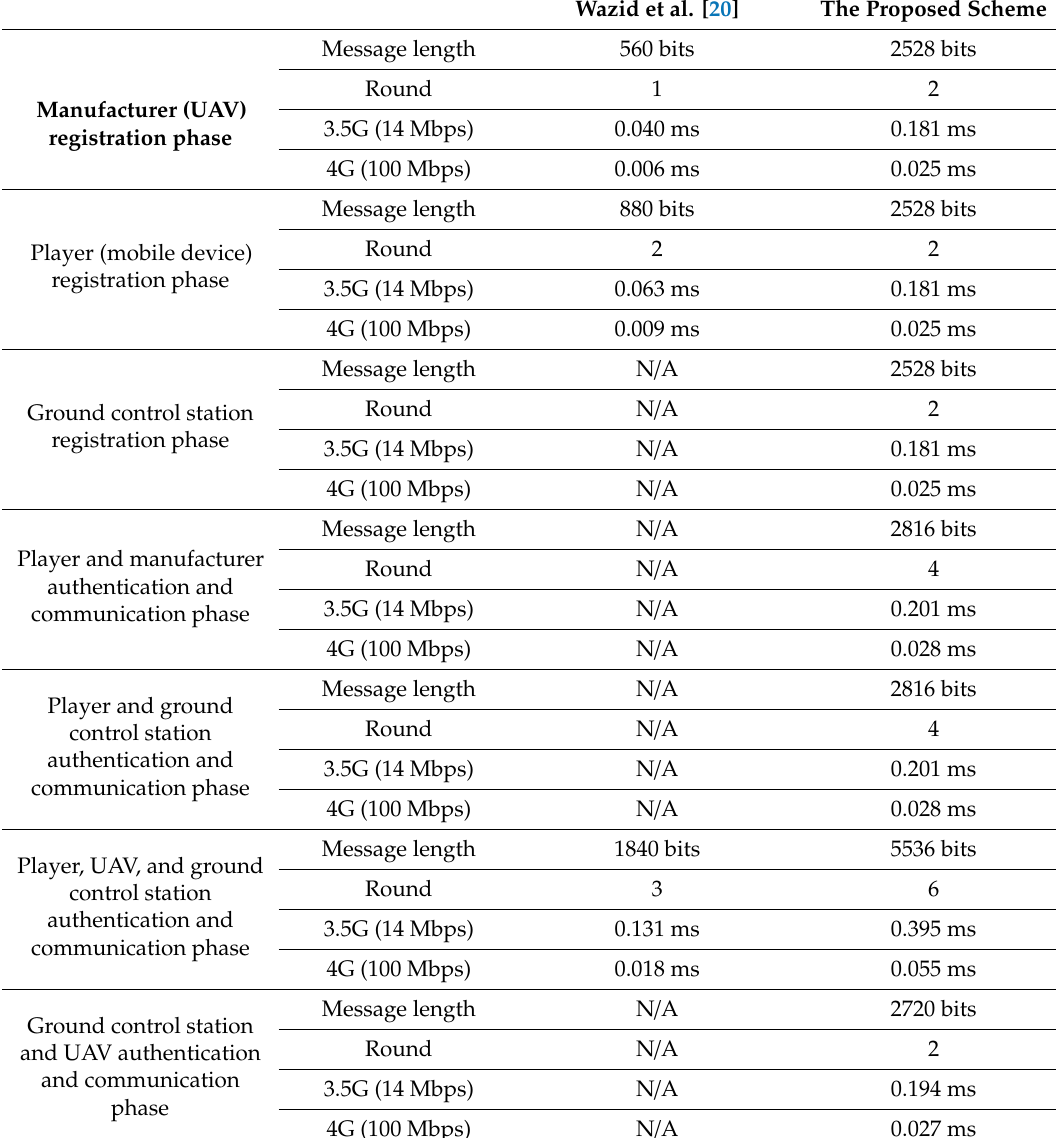
Table 4. Communication cost of the proposed scheme and Wazid et al.’s scheme [21]. Wazid et al. [20] The Proposed